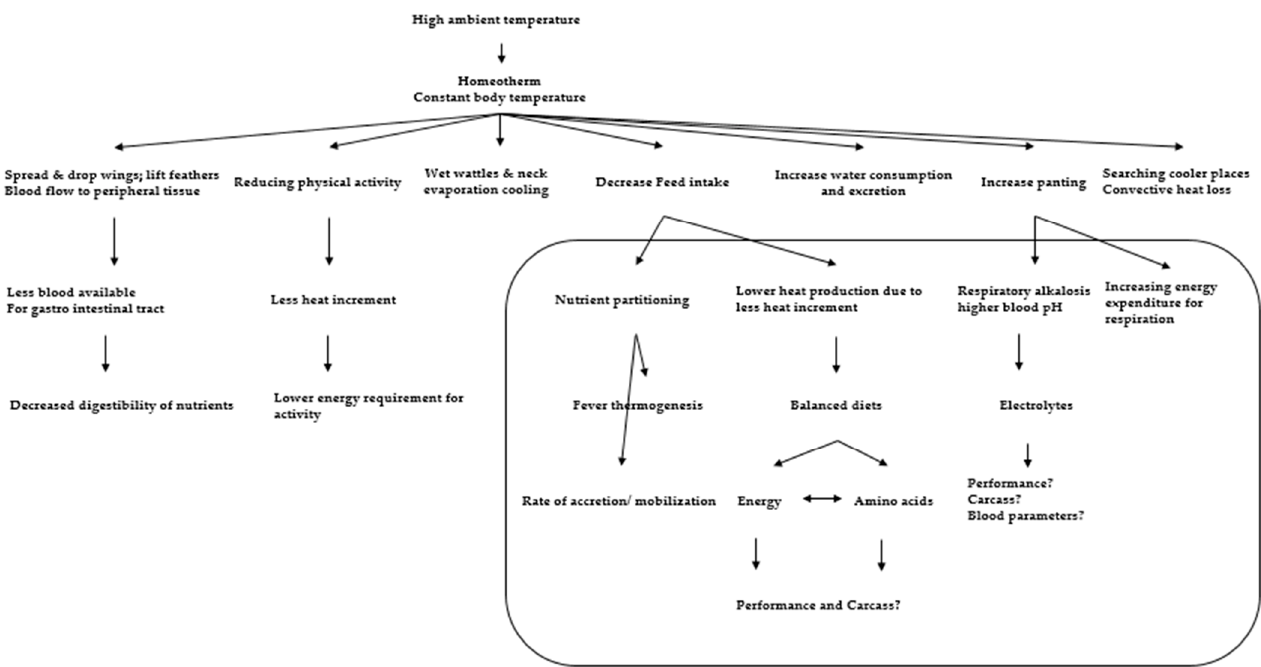
Figure 4. Behavioral and physiological adjustments of chickens at high ambient temperatures and its effects on nutrient intake and utilization. Modified after [57].